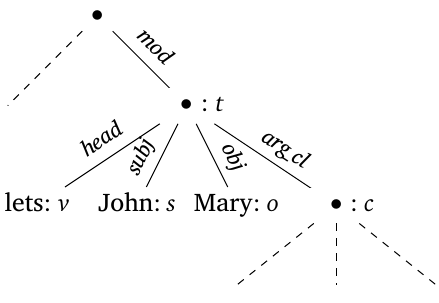
Figure 20: Instantiation of the logical constraints for the first occurrence of p